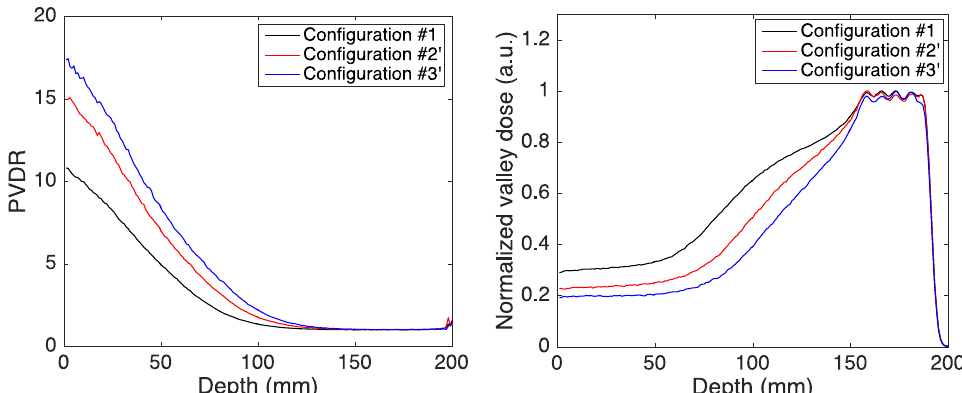
Figure 6. Peak-to-valley dose ratio as a function of depth ( left image ) and depth-dose of the first central valley ( right image ) in the three